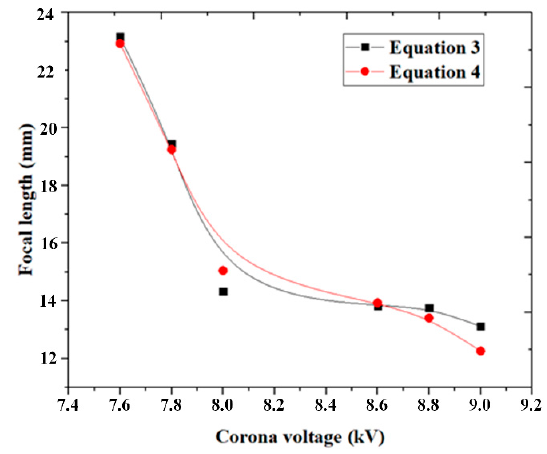
Figure 8. Focal length of the convex liquid lens as a function of the voltage.